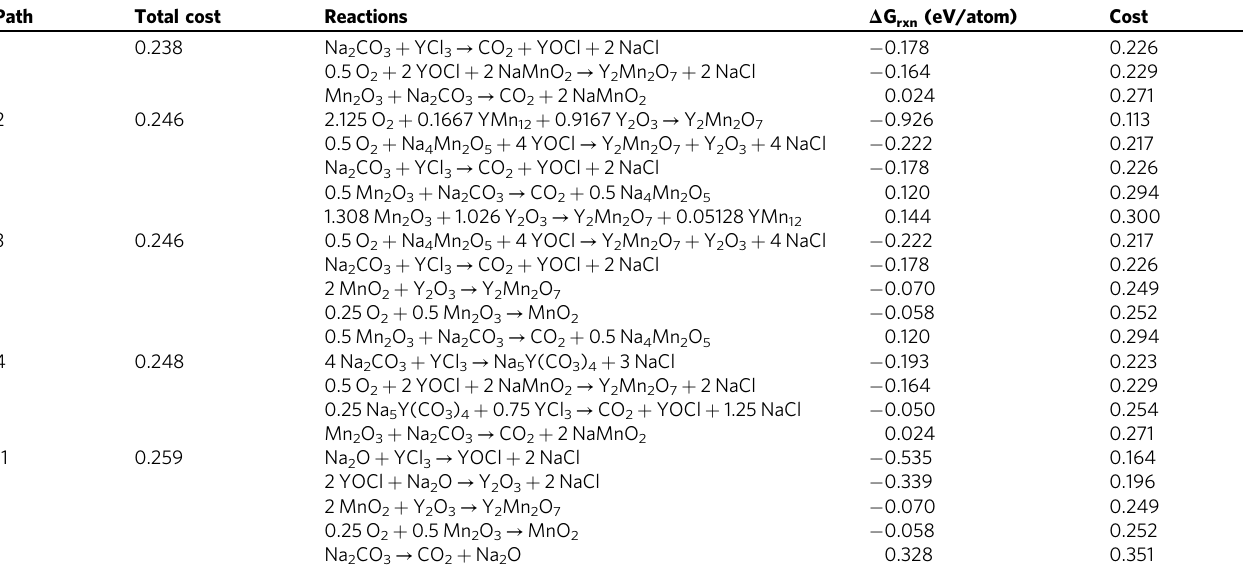
Table 2 Selection of top predicted reaction pathways to Y 2 Mn 2 O 7 .